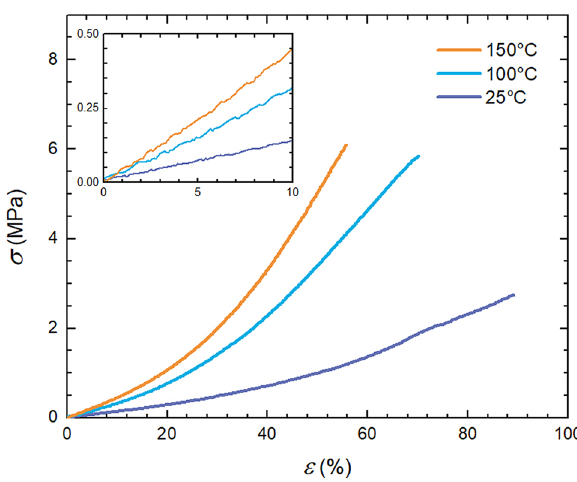
Figure 3. Tensile test curves of Sylgard 184 cured at different